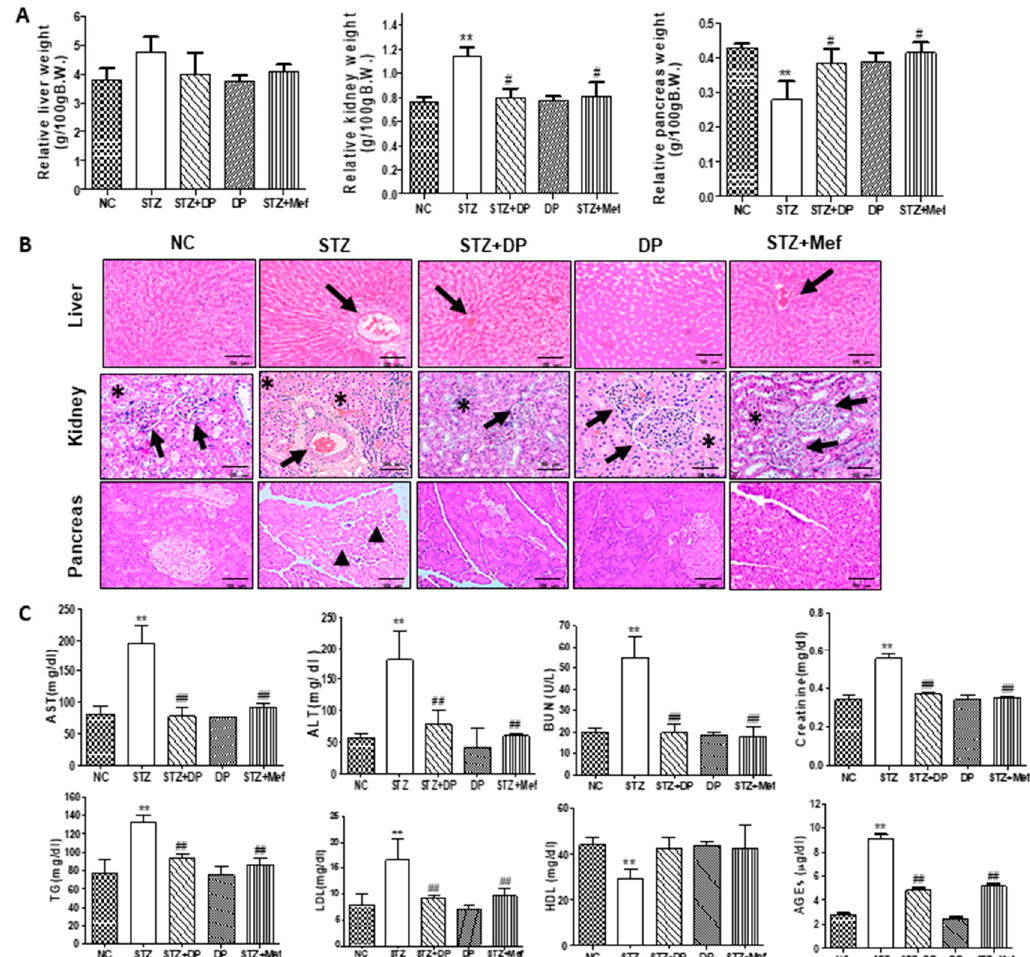
Figure 3. E ff ect of DP extract on relative organ weight, histopathological changes, and biochemical parameters in STZ-induced diabetic rats. ( A ) Relative organ weight changes in STZ-induced diabetic rats. Values are expressed as the mean ± S.D. for six rats. Statistical analysis was performed by one-way ANOVA followed by Tukey’s HSD post hoc test for multiple comparisons. ** p < 0.01 compared to vehicle control; # p < 0.05 compared to STZ-treated group. ( B ) Representative histology of hematoxylin and eosin (H&E) stained liver, kidney, and pancreatic sections from experimental groups. STZ-induced rats showed enlarged cortex with glomerular sclerosis (arrowheads) and expansion (asterisk), and they also showed dilatation. The cortex from DP extract-treated rats displayed a normal histological structure of tubules and collecting ducts. The islet cells are seen interspersed between the acinar cells. The islets appeared more lightly stained than the surrounding acinar cells. STZ-induced diabetic rats revealed pathological changes in the acinar cells, which were observed as swollen and small vacuoles (black arrowheads). Islet β -cells are almost entirely lost in STZ-induced diabetic rats. However, the administration of DP extract showed distortion of the general architecture. An atrophic change of the acinar cells was less severe, and the border between exocrine and endocrine portions became more distinct. Images are representative of three animals per experimental group (magnification 100 × ). ( C ) E ff ect of DP extract on biochemical parameters. Values are expressed as the mean ± S.D. for six rats. Statistical analysis was performed by one-way ANOVA followed by Tukey’s HSD post hoc test for multiple comparisons. ** p < 0.01 compared to vehicle control; ## p < 0.01 compared to the STZ-treated group.